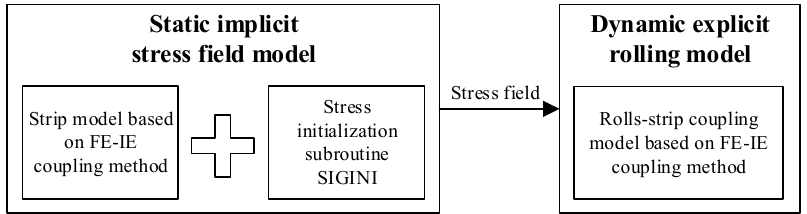
Figure 3. Simulation technique route.